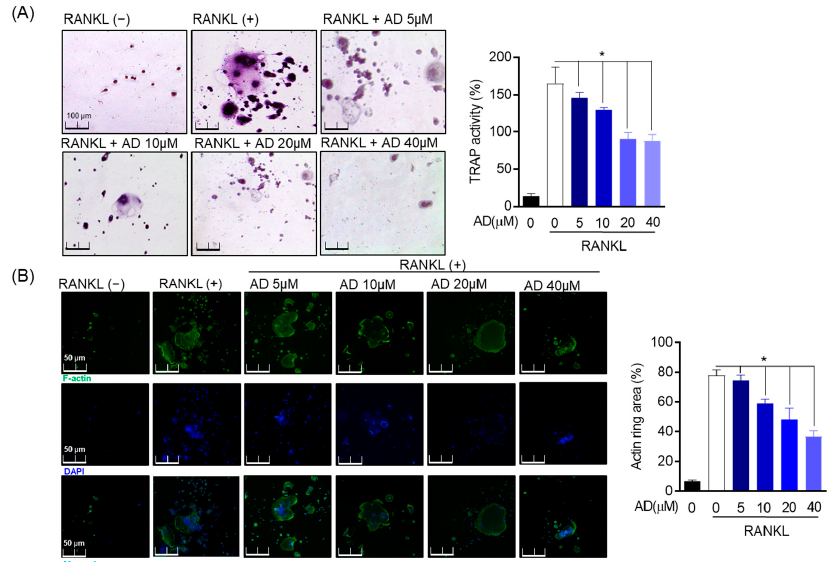
Figure 3. Inhibitory effect of AD on RANKL-induced osteoclast differentiation and formation. ( A ) RAW 264.7 cells (1 × 10 3 cells/well) were cultured in 24-well culture plates, then treated with AD (5–40 µM) for 5 days. After culture, TRAP staining and activity were analyzed. ( B ) RAW 264.7 cells were treated in the presence or absence of AD and stimulation of RANKL (50 ng/mL) for 5 days to investigate the formation of osteoclast, Alexa 488-Phalloidin (green), and DAPI (blue) was used to stain the actin cytoskeleton and counterstained the nuclei, respectively. * p < 0.05, versus the RANKL-treated group.